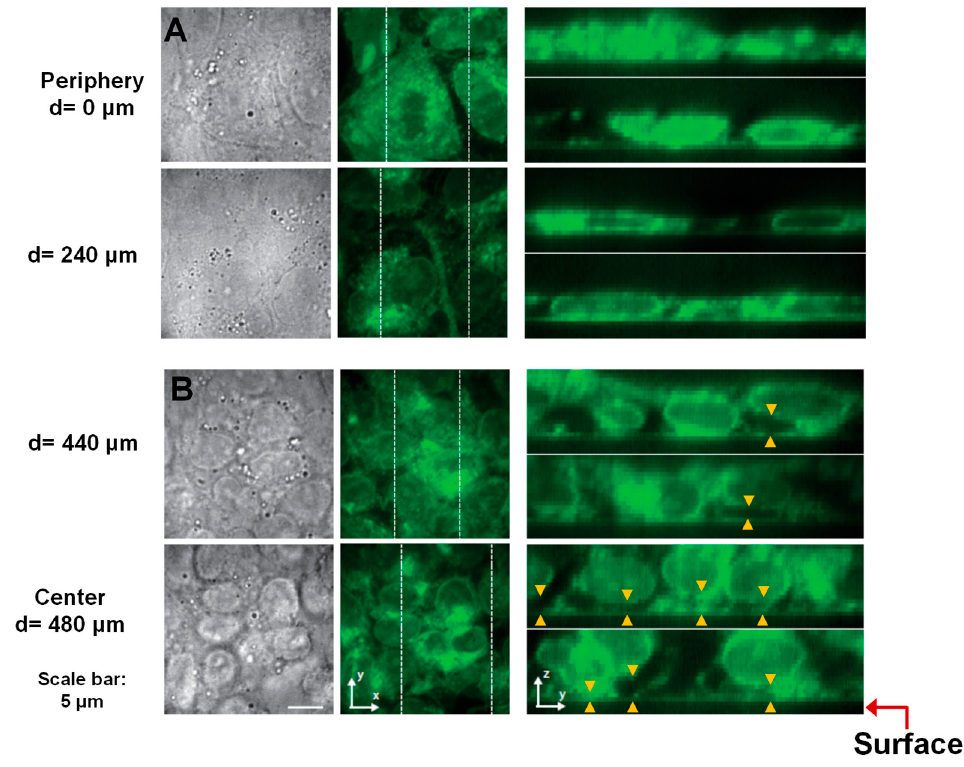
Figure 3. 3D confocal microscopy images of EpiSC colonies reveal a significant gap between cells and the fibronectin-coated surface in the colony center. Brightfield (left) and fluorescence images of EpiSC colonies in the x–y (middle) and y–z planes (right) at different locations are shown. The y–z sections were taken from the 3D image stacks indicated by white dashed lines in the x–y sections. Cells were stained with CellMask green plasma membrane dye. 3D image stacks of fluorescence images were obtained by multiline scanning confocal microscope. The brightfield images were obtained 2 µ m above the surface. A red arrow indicates the surface. Cells on the periphery establish good contact with fibronectin that promotes differentiation ( A ). In contrast, cells in the colony center show significant gaps between the cells and the surface, thereby decreasing cell–ECM interactions ( B ; arrowheads). Cells in the colony center have been lifted away from the surface by 1–2 µm, on average, and in some places by > 3 µm. Scale bar, 5 µm.